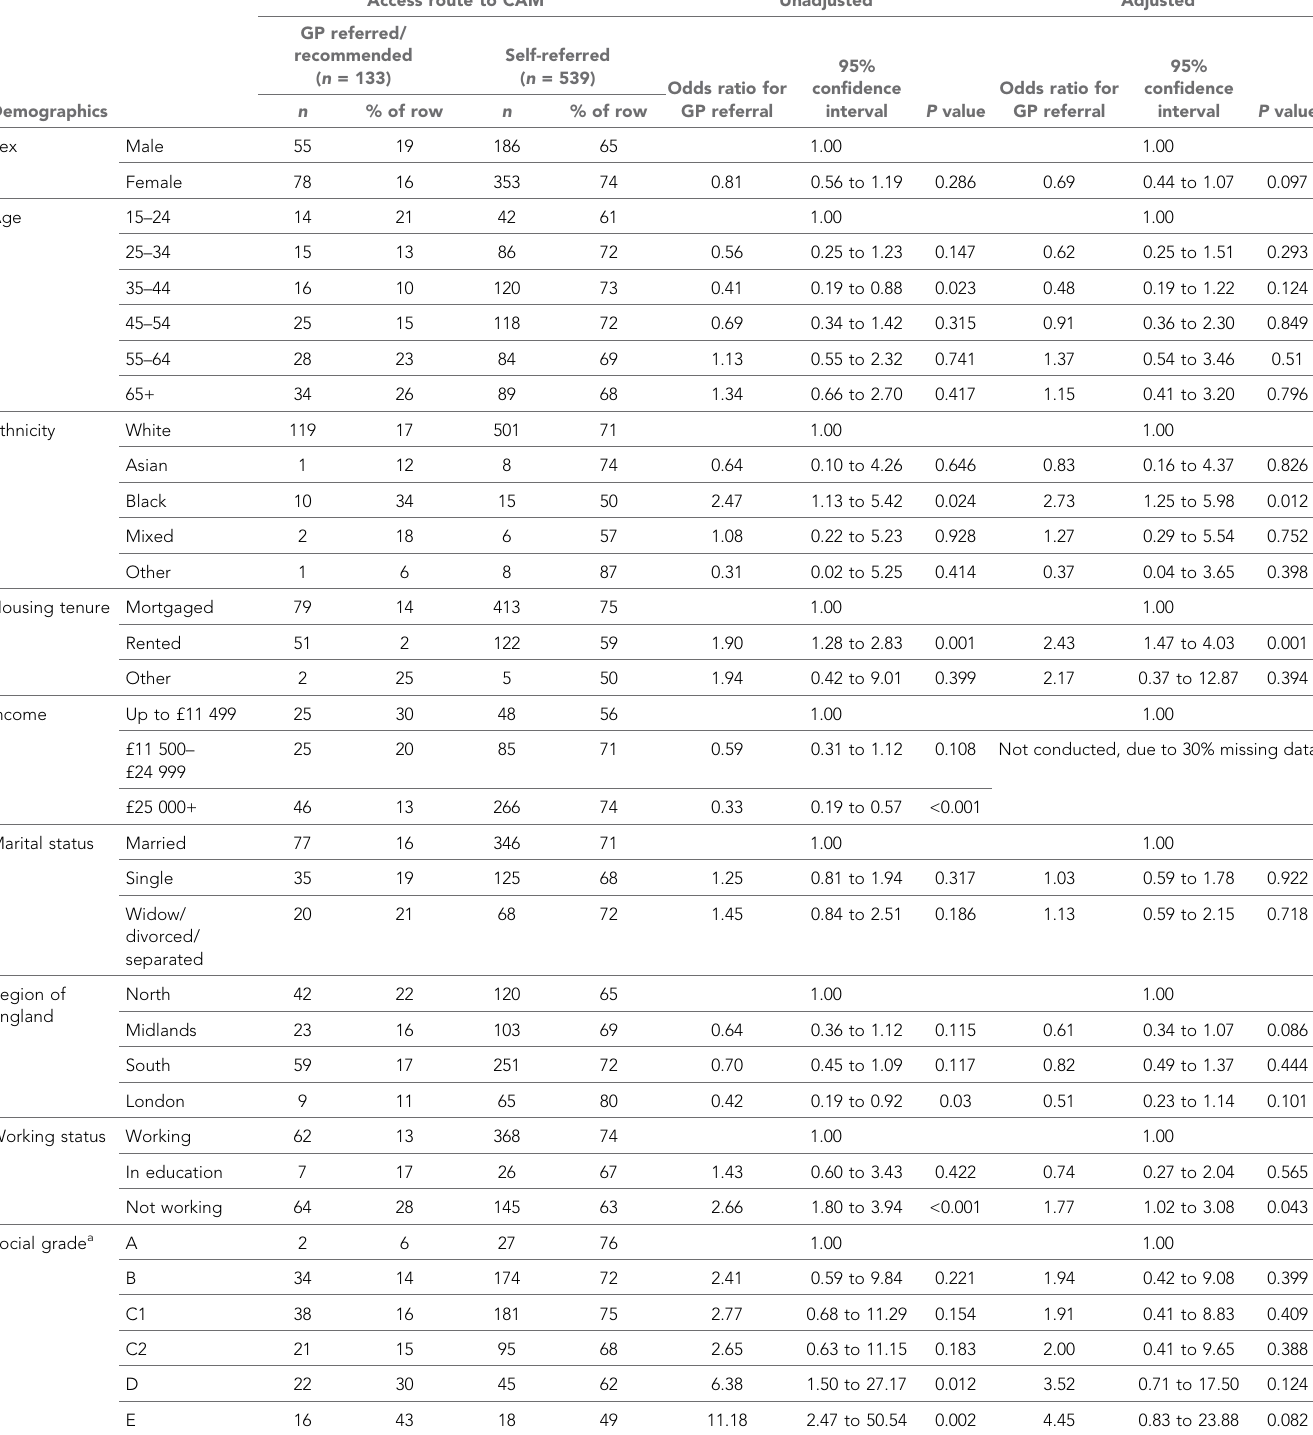
Table 6 Cross tabulation of demographics and access route to CAM